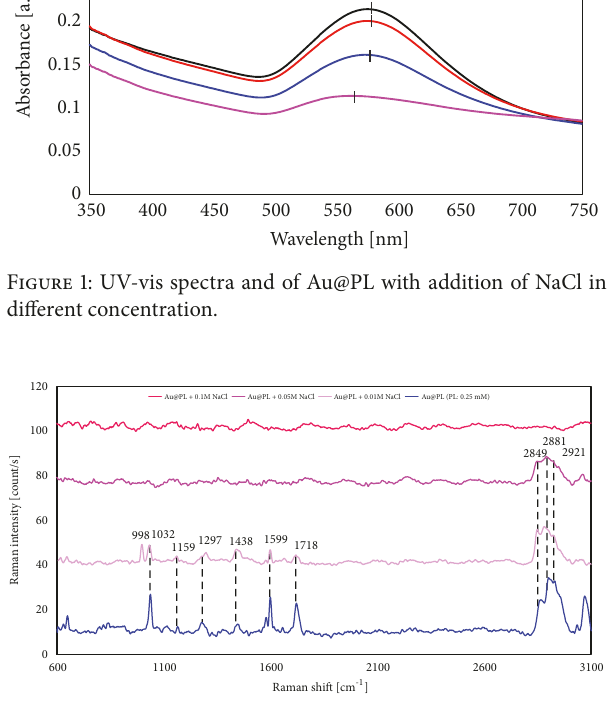
Figure 2: Raman spectra and of Au@PL with addition of NaCl in different